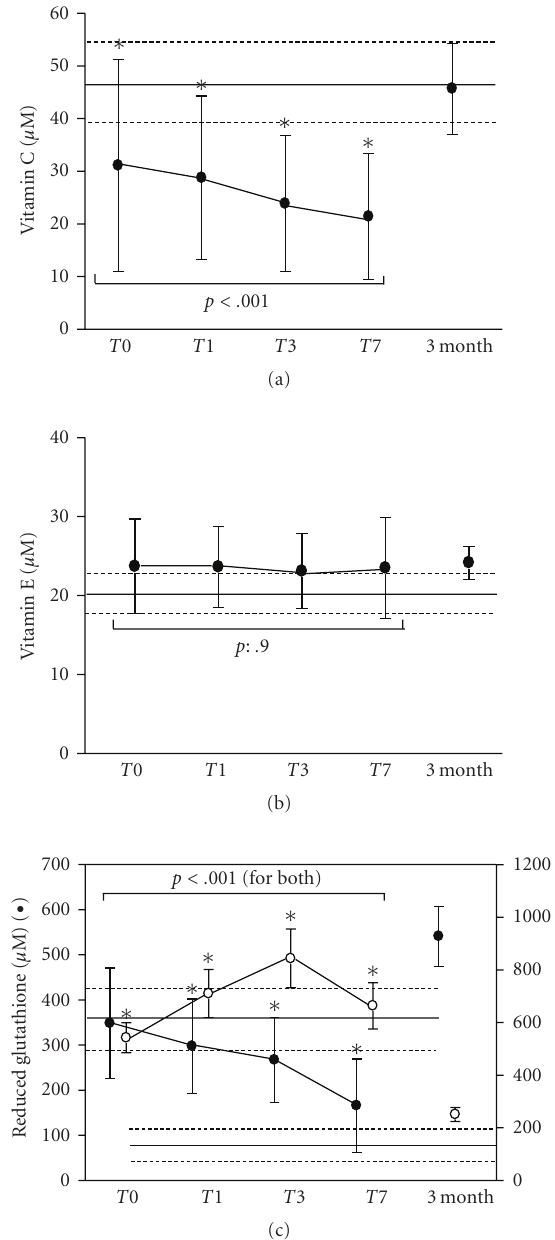
Figure 2: Evolution of antioxidant levels in all septic shock patients of (a) Vitamin C, (b) Vitamin E (alpha-Tocopherol), and (c) reduced and oxidized glutathione. Normal values (mean ± SD) obtained from matched healthy subjects are shown as continuous and dotted lines, respectively. p : reflects variation in time calculated by linear mixed e ff ects model. ∗ Indicates significant di ff erences between normal values and patients at di ff erent time points ( t -test for independent samples).